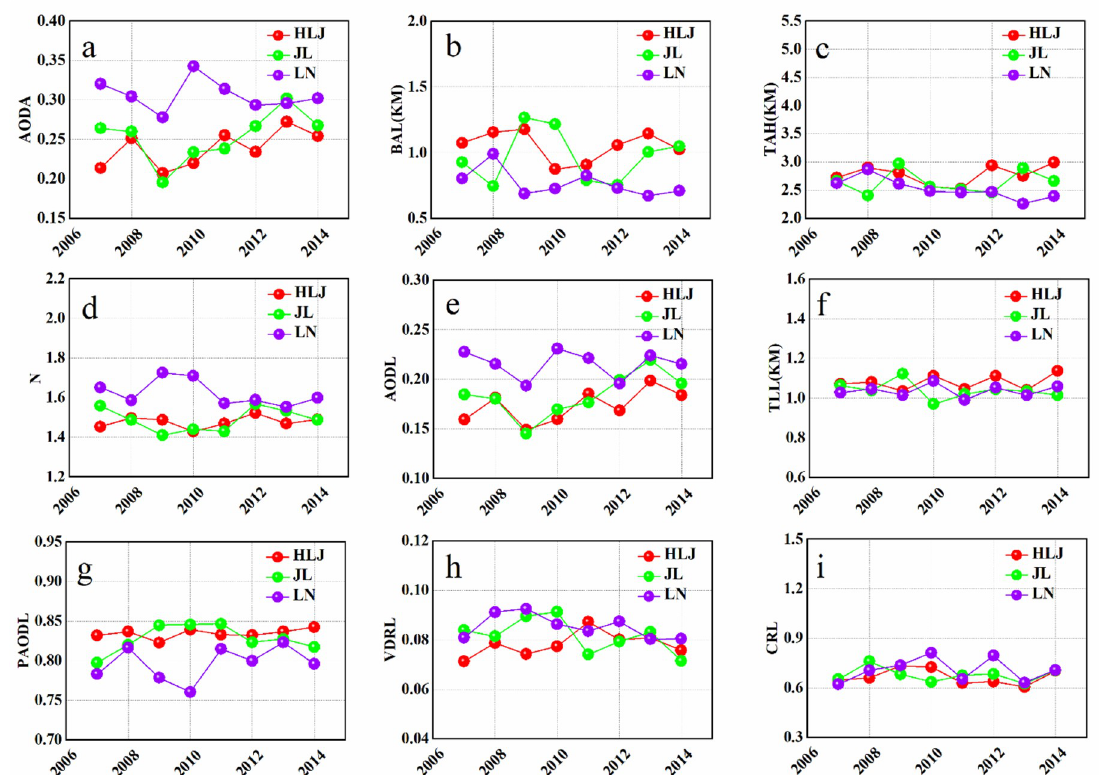
Figure 2. Inter-annual variations in the optical and physical properties of aerosol layers over NEC (Heilongjiang province (HLJ), Jilin province (JL), and Liaoning province (LN)) in the daytime from 2007 to 2014. ( a ) The AOD of all the aerosol layers (AODA), ( b ) the base altitude of the lowest aerosol layer (BAL), ( c ) the top altitude of the highest aerosol layer (TAH), ( d ) the number of aerosol feature layers (N), ( e ) the AOD of the lowest aerosol layer (AODL), ( f ) the thickness of the lowest aerosol layer (TLL), ( g ) the AOD proportion of the lowest aerosol layer (PAODL), ( h ) the volume depolarization ratio of the lowest aerosol layer (VDRL), and ( i ) the color ratio of the lowest aerosol layer (CRL).